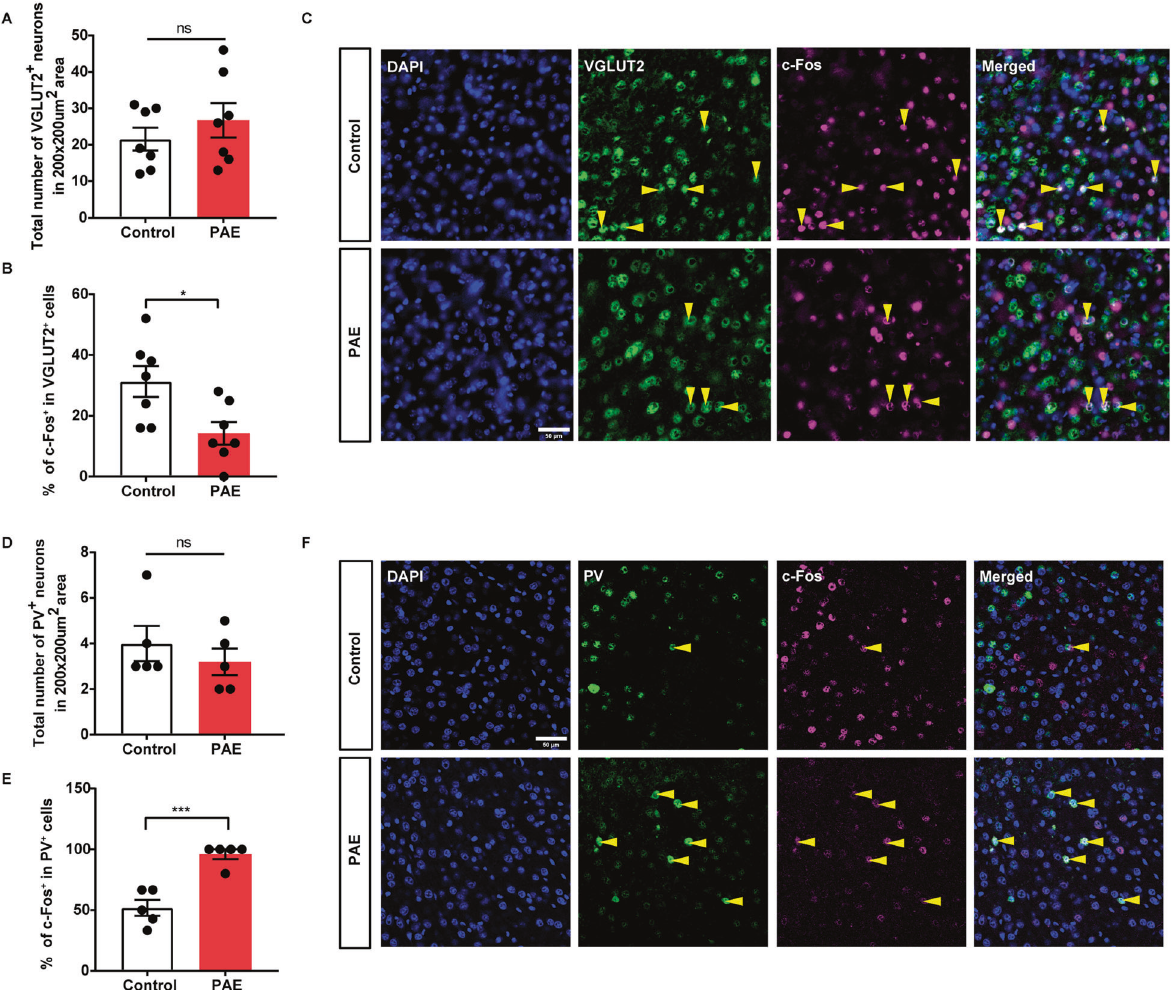
Fig. 3 Imbalance of excitatory and inhibitory activities in the ACC in the PAE mice. Immunohistochemistry was performed to detect activation of excitatory (VGLUT2 + ) or inhibitory (PV + ) neurons via c-Fos staining in the animals 60 min after the EPM test, and the number of cells with colocalized signals was quanti fi ed in the ACC. A , B There was no difference in the total number of VGLUT2 + cells between control and PAE mice. PAE mice showed a signi fi cantly lower number of VGLUT2 + neurons that are also c-Fos + compared to control mice (* p = 0.0188). n = 7 mice each. C Representative images of immunohistochemical detection of VGLUT2 and c-Fos on the coronal brain slices from the PAE and the control mice post EPM test. Yellow arrowheads indicate cells that express both VGLUT2 and c-Fos. Scale bar = 50 µm. D , E No difference in the total number of PV + cells between control and PAE mice was observed. The number of PV + cells that co-express c-Fos was signi fi cantly reduced in the PAE (*** p = 0.0004). n = 5 mice each. F Representative images of PV and c-Fos colocalized cells. Scale bar = 50 µm. A , B , D , E Graphs represent mean ± SEM, and each dot represents an individual animal. Unpaired two-tailed Student ’ s t -test. ns not signi fi